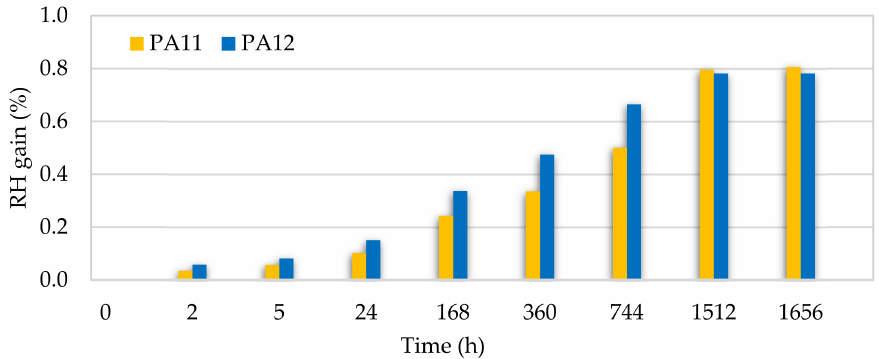
Figure 15. Moisture gain of PA11 and PA12 at different aging